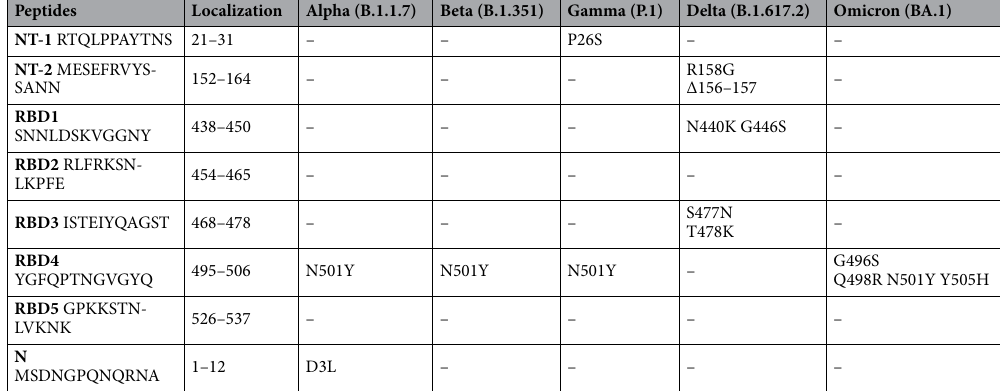
Table 3. Amino acid changes and deletions in SARS-CoV-2 variants of concern and their localization in the selected peptides. *Amino acid changes and deletions of each variants were collected from the database CoVariants (https:// covar iants. org/ varia nts). Δ: Deletion.